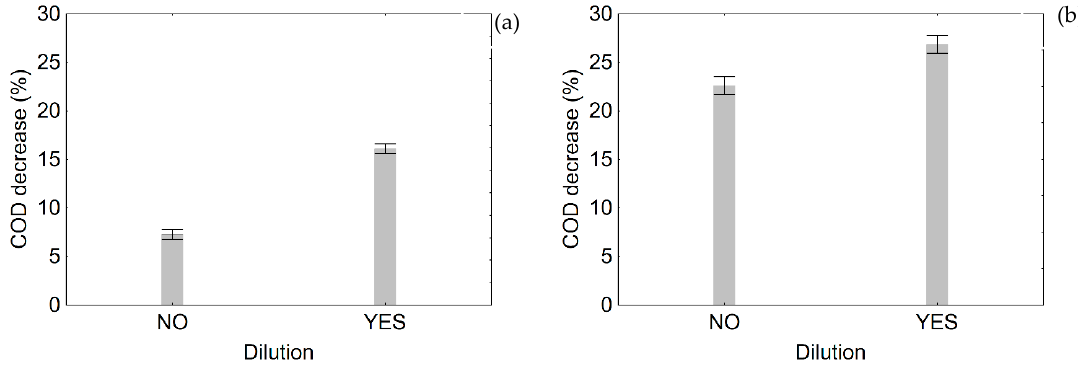
Figure 10. Effect of dilution on the performances of Bacillus/Candida ( a ) and T. harzianum ( b ) on the reduction of COD. Decomposition of the statistical hypothesis. Bars denote 95% confidence intervals.